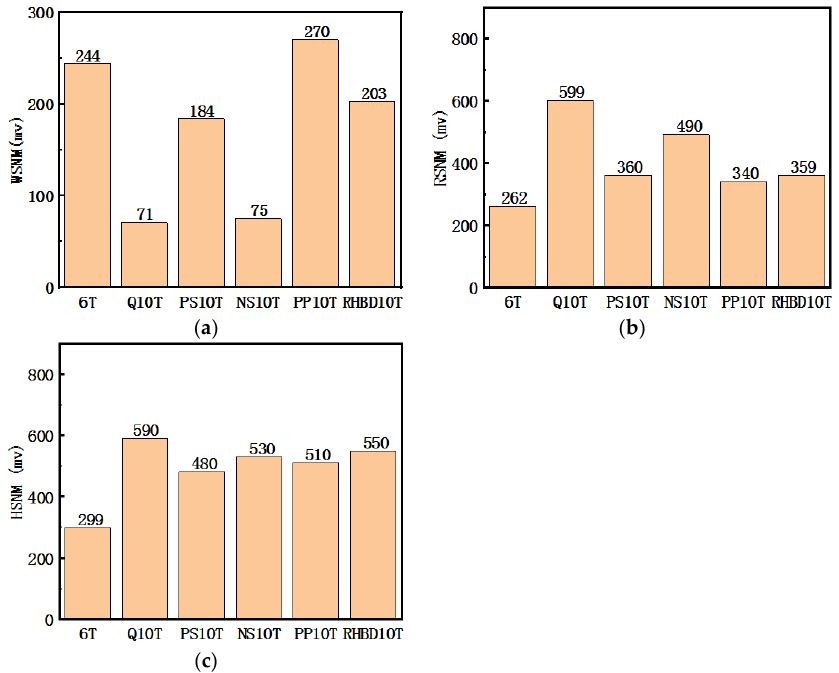
Figure 6. Static noise margin comparison: ( a ) WSNM, ( b ) RSNM., and ( c ) HSNM.